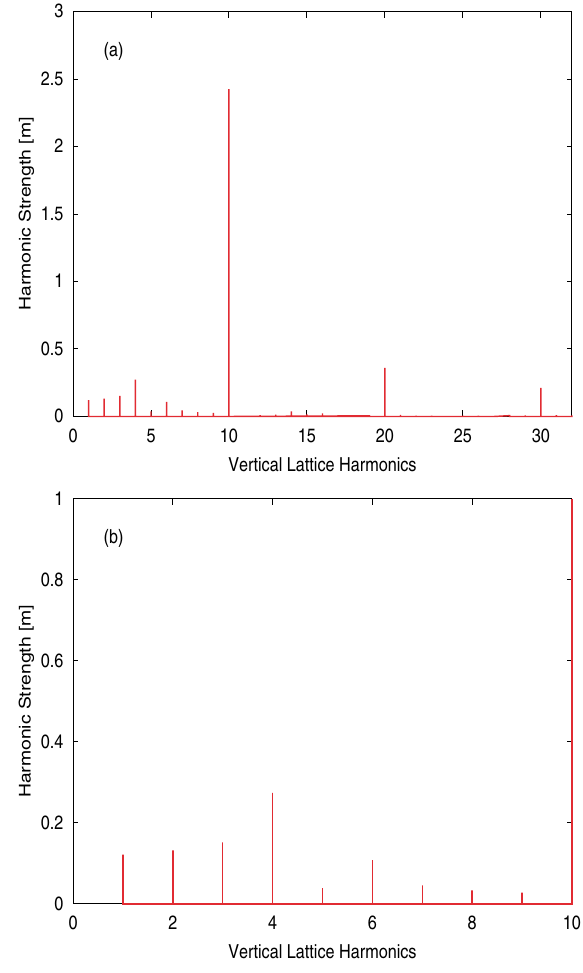
FIG. 3. (Color) Vertical coherent resonance response curves for the PSR lattice (red (cid:1) ’s), and for an equivalent uniform- focusing approximation (blue (cid:13) ’s).